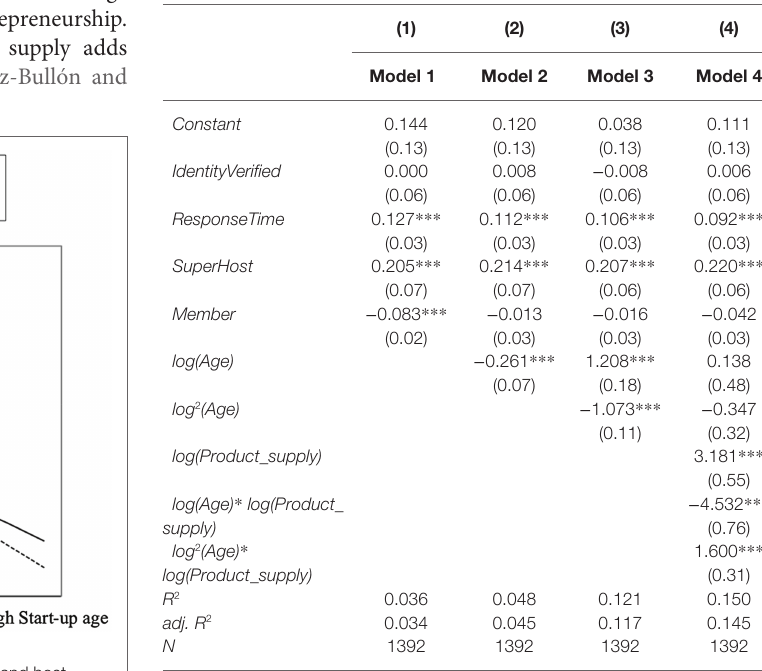
TABLE 4 | Robustness regression